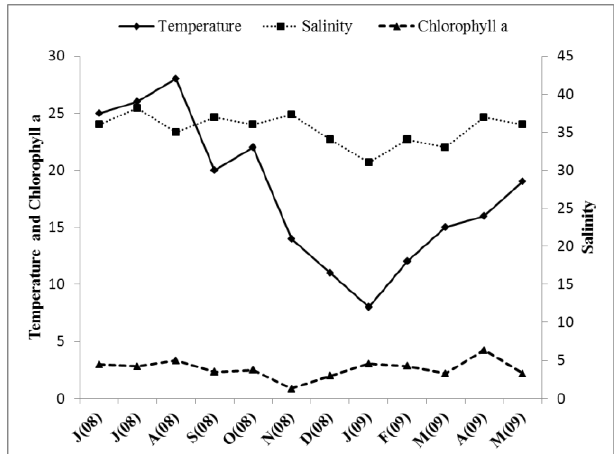
Figure 2. Physicochemical parameters of Kalaât El Andalous during the sampling period (Jun 2008–May 2009).